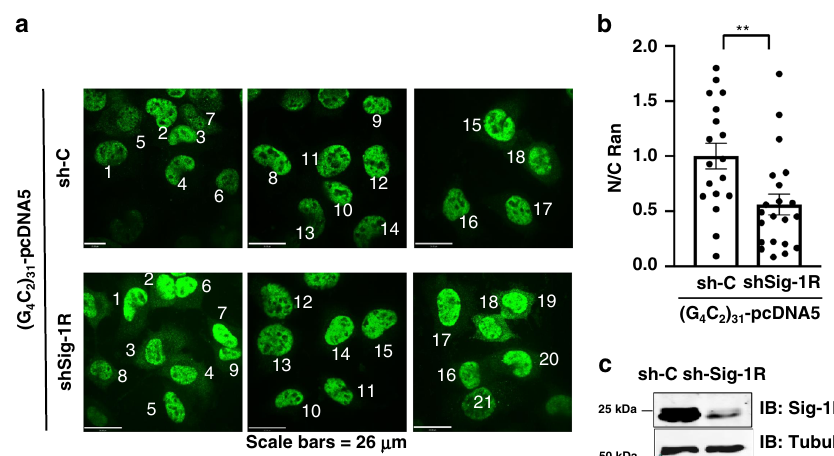
Fig. 6 Sig-1R knockdown exacerbates the increase of cytoplasmic Ran caused by (G4C2)31-RNA: Imaging analyses. a The shRNA control (sh-C) or Sig- 1R-shRNA (shSig-1R) vector was transiently transfected into HeLa cells for 24 h. The (G 4 C 2 ) 31 -RNA vector was then transfected into HeLa cells to produce the (G 4 C 2 ) 31 -RNA in the cell. Distribution of endogenous Ran (in green) was detected by immunostaining and confocal microscopy. b The semi- quanti fi cation of cytosolic or nuclear Ran was performed by using NIH Image J. (version 1.51b). Data are presented as means ± SEM; n = 18 for biologically independent control cells receiving scrambled shRNA plus (G 4 C 2 ) 31 -RNA; n = 21 for biologically independent cells receiving shSig-1R plus (G 4 C 2 ) 31 -RNA. Two-tailed unpaired Student ’ s t test, p = 0.0056. ** p < 0.01. c The knockdown ef fi ciency of Sig-1R protein in experiment above was detected by western blot. In this experiment, shSig-1R was transfected twice, i.e., 24 h after the fi rst transfection the second transfection was carried out. Sig-1R, Sigma-1 receptor; Ran, ras-related nuclear protein. n = 3 ( a ) and n = 2 ( b ) independent experiments with similar results from biologically independent cells or cellular preparations.